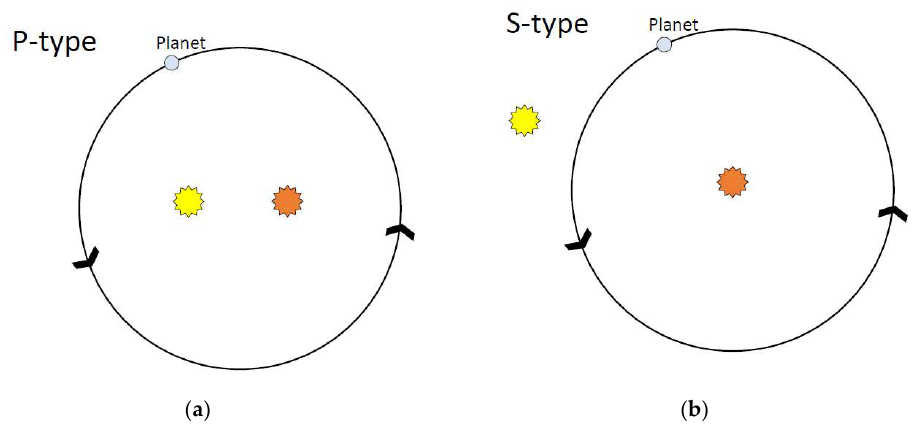
Figure 13. Schematic of P-type ( a ) and S-type ( b ) binary star systems.